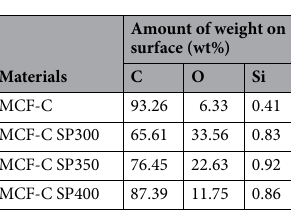
Table 2. Amount of each element adjacent the surface of catalyst granule obtained from EDX.